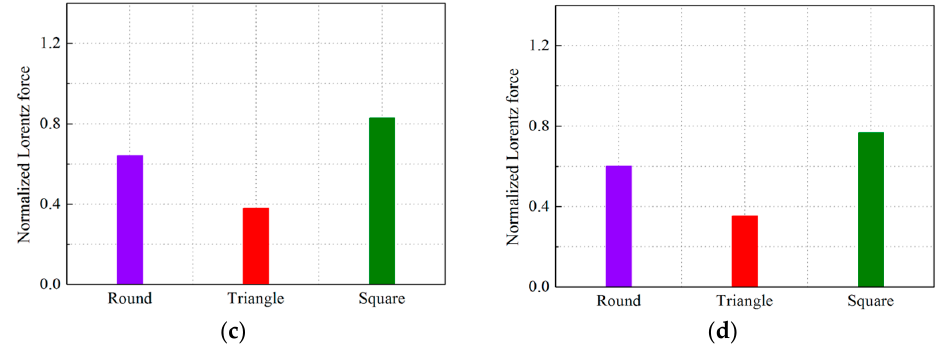
Figure 6. Normalized Lorentz force in skin depth with different coil wires’ cross-sectional shapes. ( a ) f = 1 MHz; ( b ) f = 1.5 MHz; ( c ) f = 2 MHz; ( d ) f = 2.5 MHz.